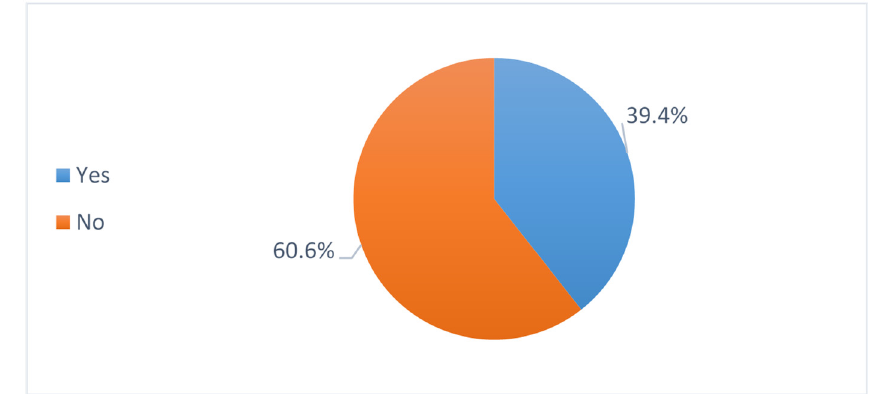
Figure 6. Prescribing of antibiotics based on laboratory